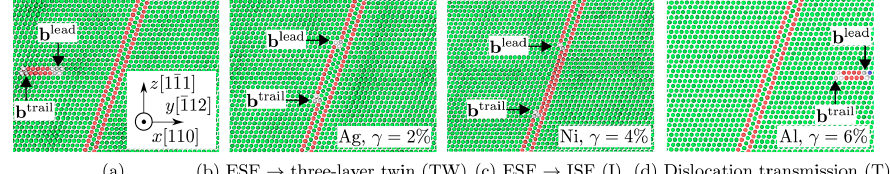
Figure 5. Atomic configurations of ( a ) a screw dislocation approaching the ESF (reaction 1) and range of observed reactions that includes ( b ) transformation of the ESF into a three-layer twin (TW, reaction 4), ( c ) transformation of the ESF into an ISF (I, reaction 3), and ( d ) transmission of the screw dislocation across the ESF (T, reaction 1). The applied shear strain γ zx is zero in ( a ). The Burgers vectors of the leading (lead) and trailing (trail) partial dislocations are given in the corresponding reactions. Atoms are colored in the same way as in Figure 2, and the view is illustrated in ( a